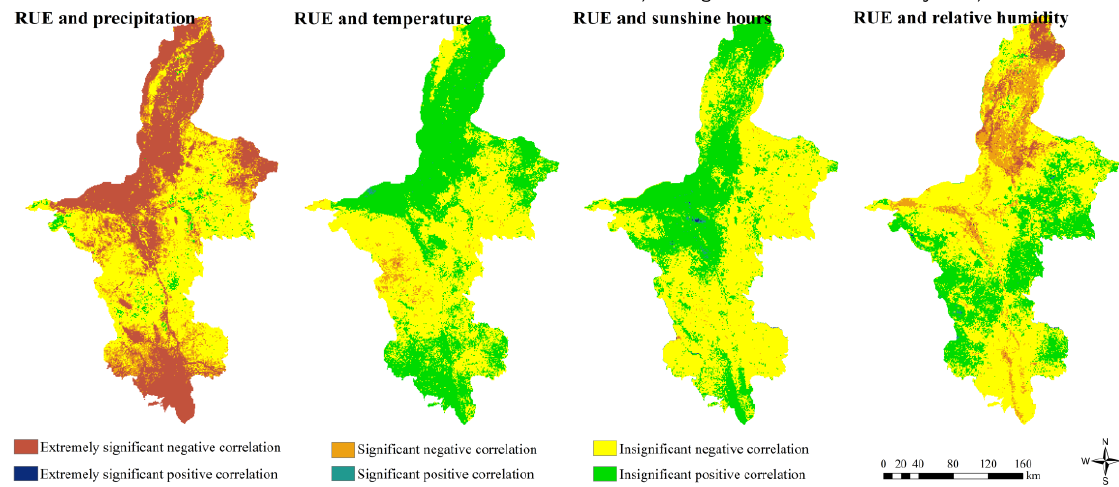
Figure 6. Correlation coefficient of RUE and meteorological factors